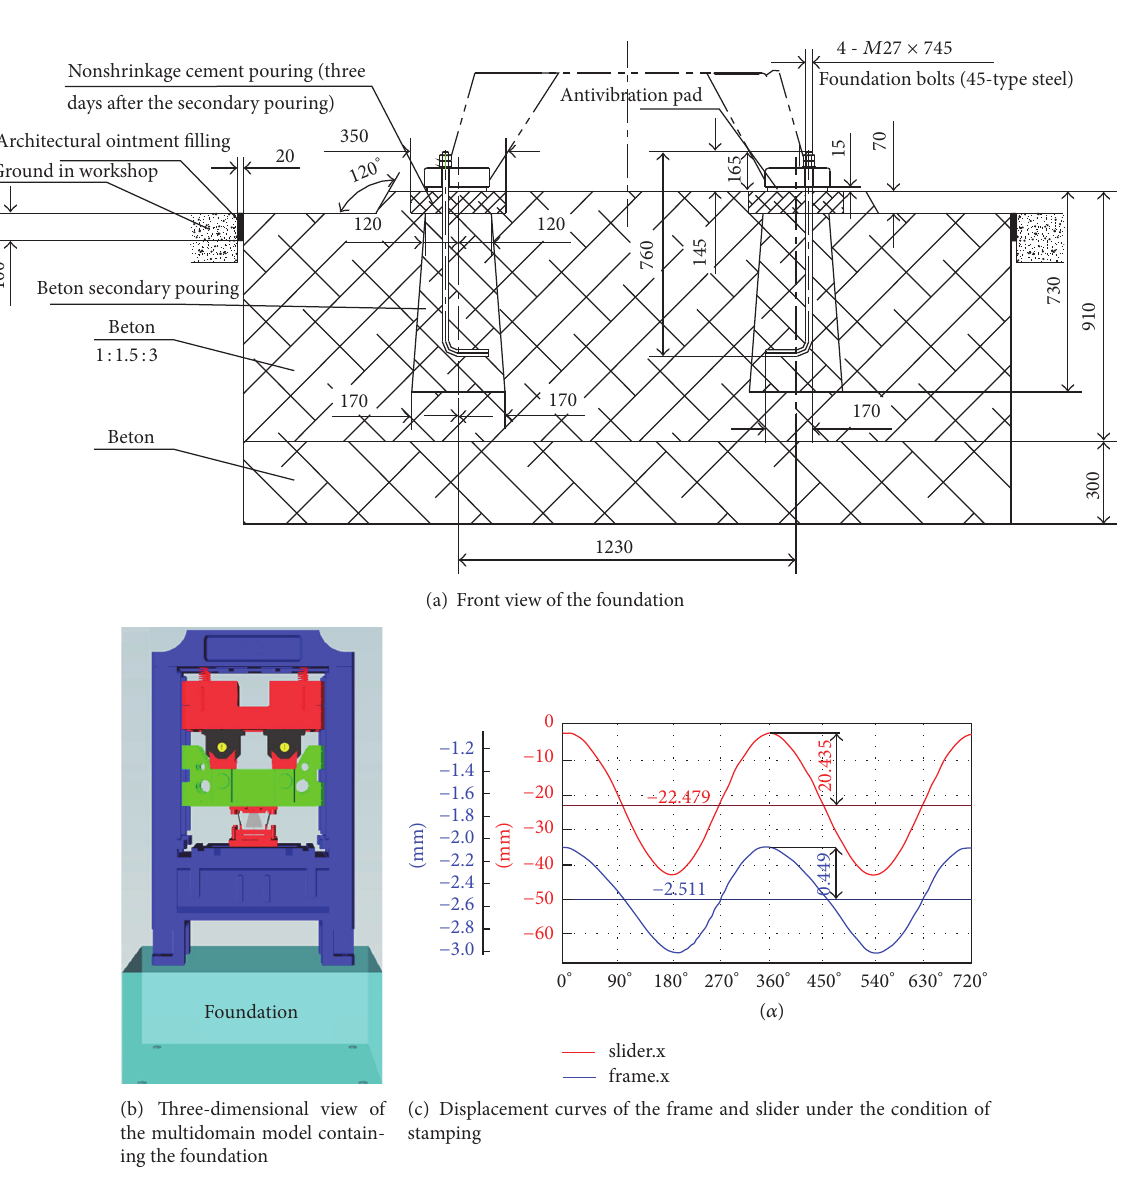
Figure 17: Foundation originally designed for the high-speed precision servo punching